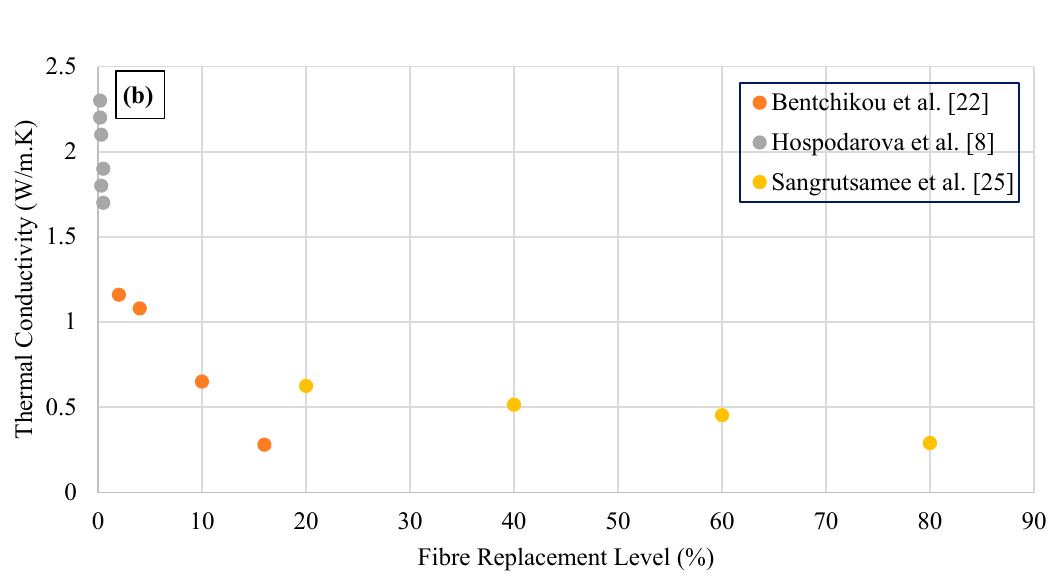
Figure 6. ( a ) Water absorption and ( b ) thermal conductivity variation of waste paper/cardboard cement composite binders.